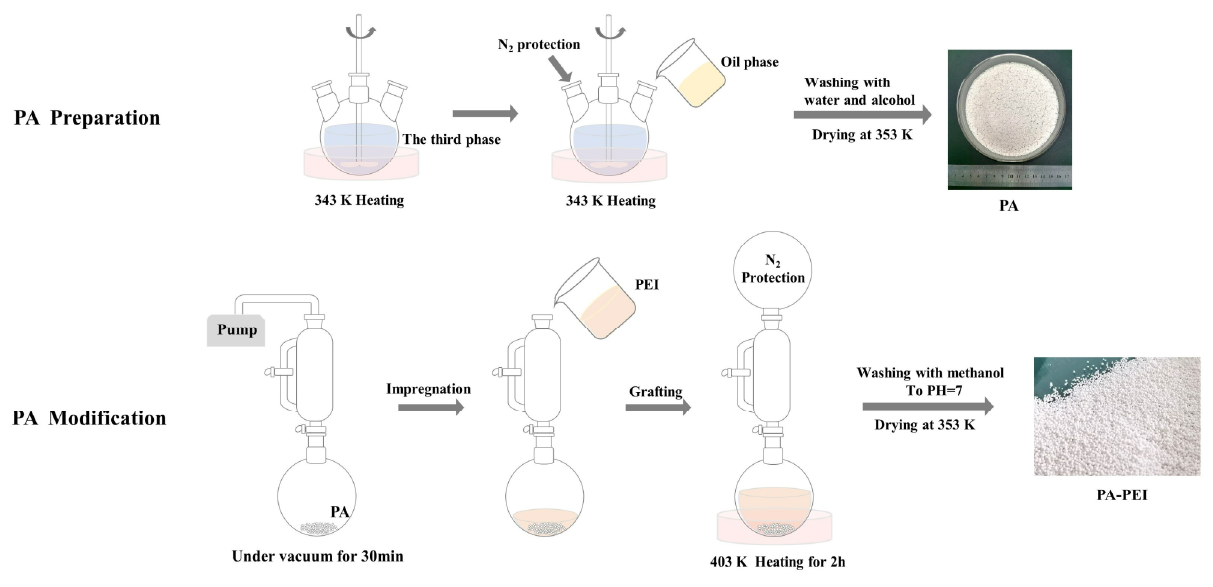
Figure 1. Schematic of the preparation of PA and PA−PEI.